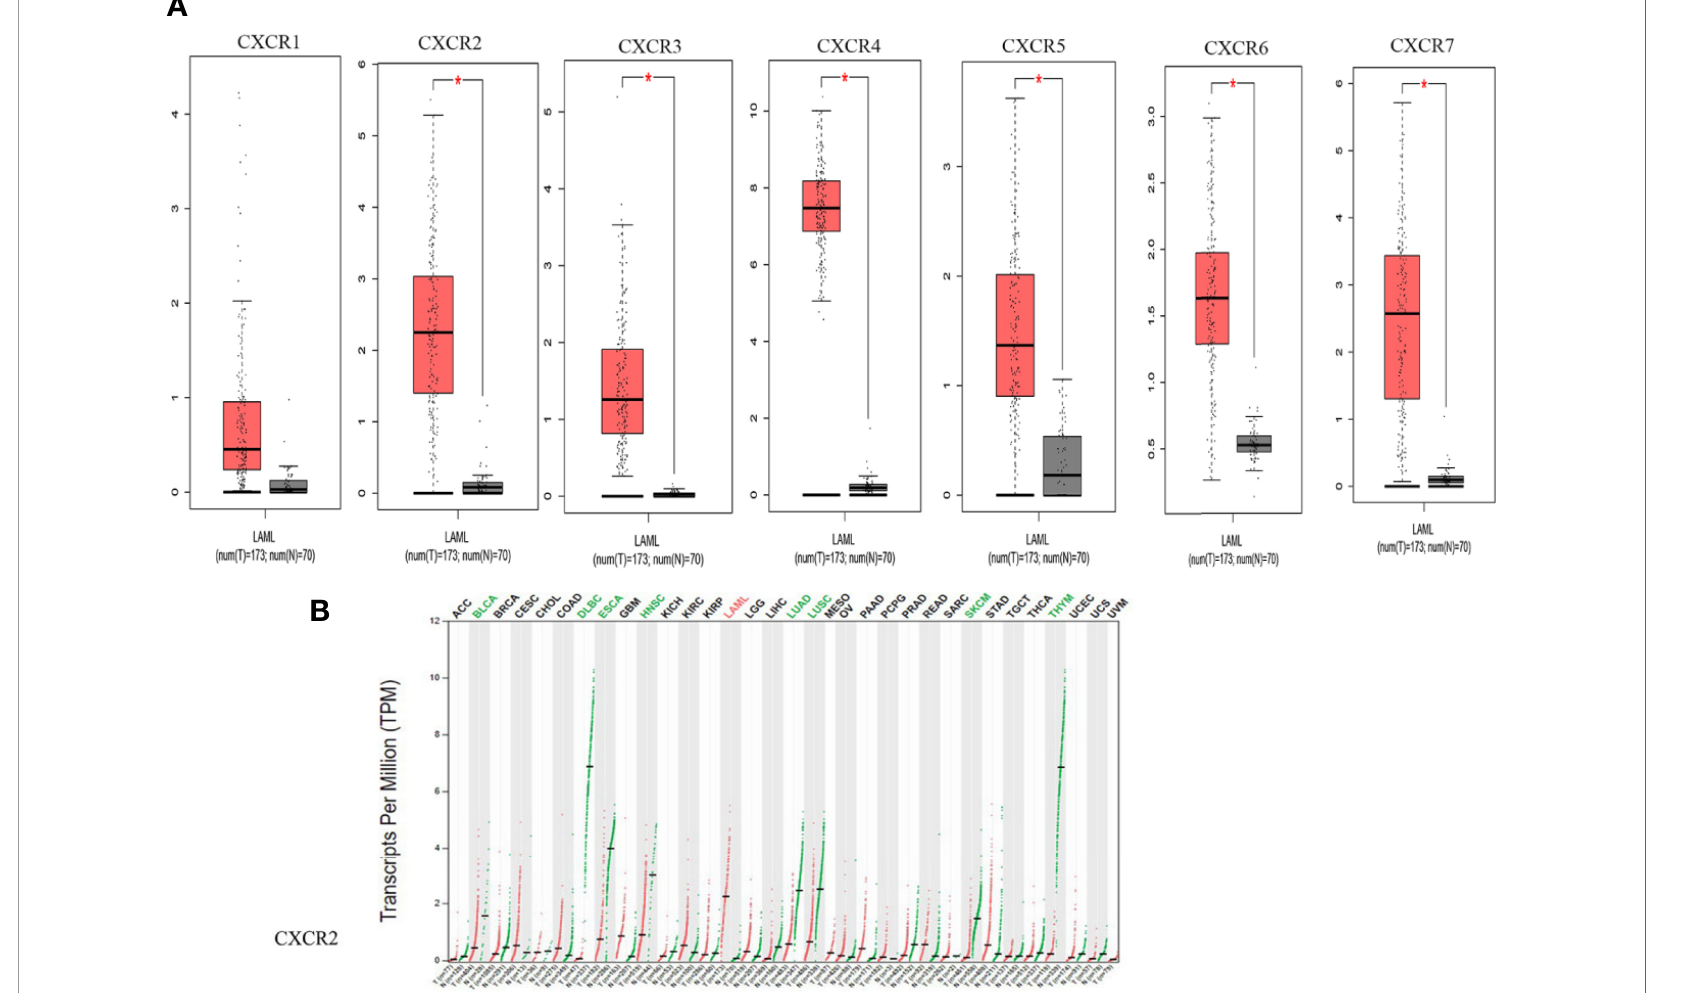
FIGURE 1 | The mRNA expression from GEPIA. (A) CXCRs between AML and normal samples. (*P < 0.05). (B) CXCR2 expression pro fi le across all tumor samples and paired normal